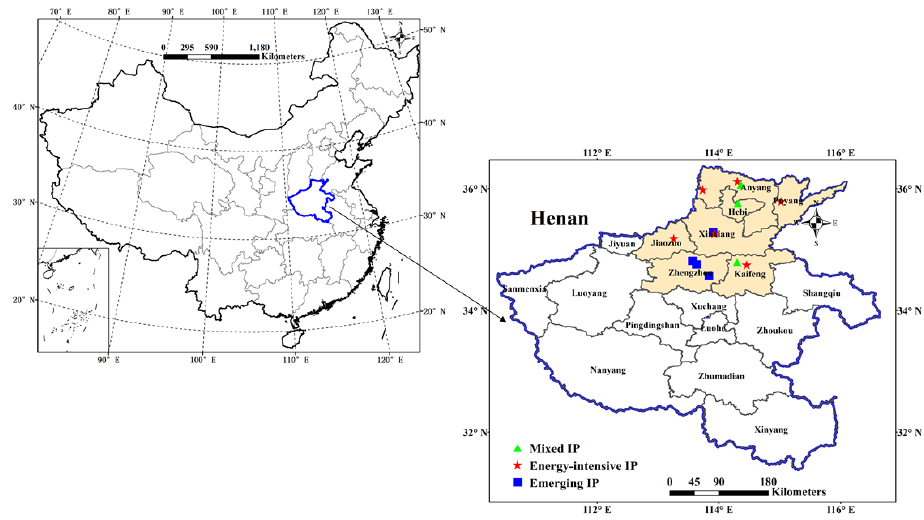
Figure 1. Geographical distribution of the industrial parks in seven cities.